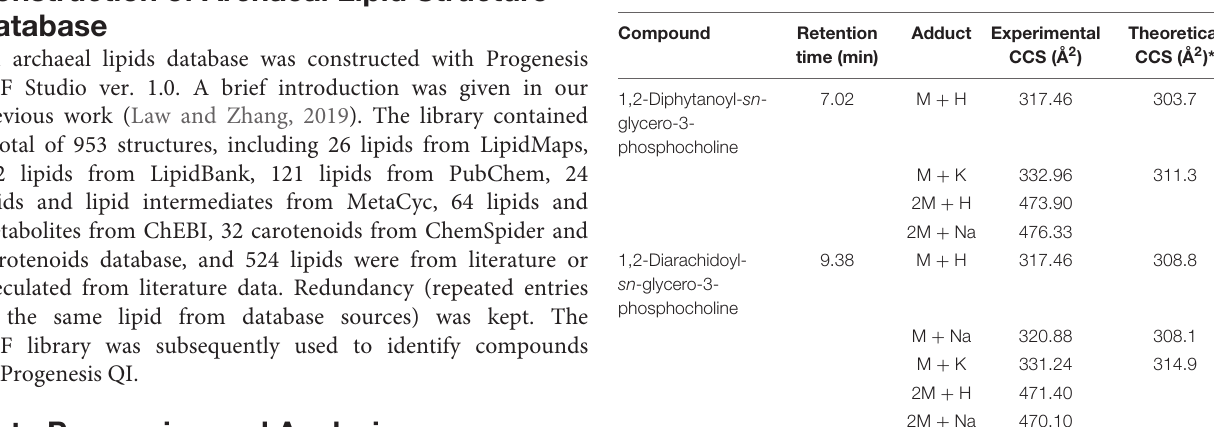
TABLE 1 | The CCS values of various adducts of the isomeric lipid pair.